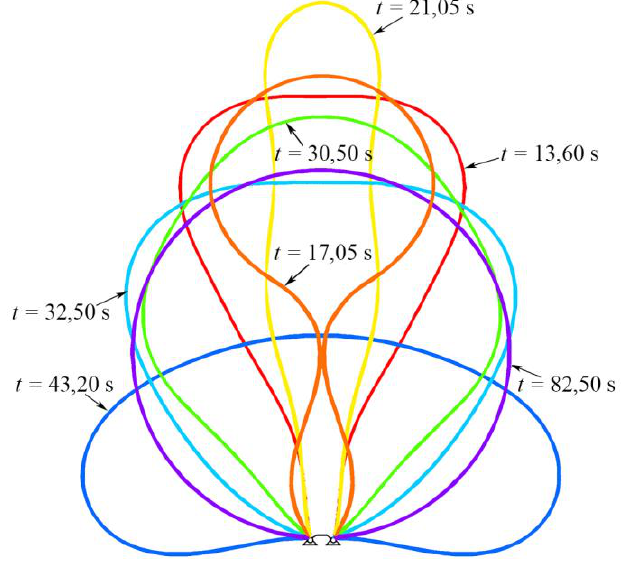
Fig. 5 . Intermediate shapes of unfolding of the closed load-bearing